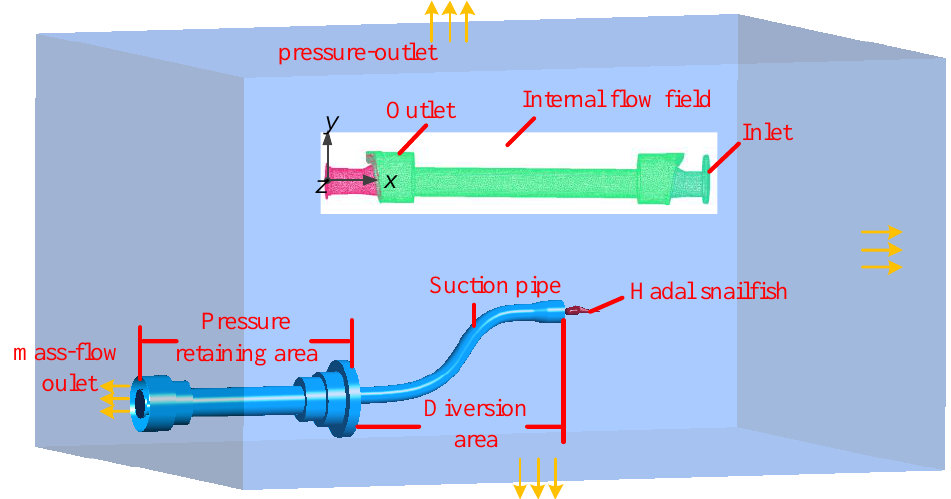
Figure 4. Fluid calculation model of HSMPS.